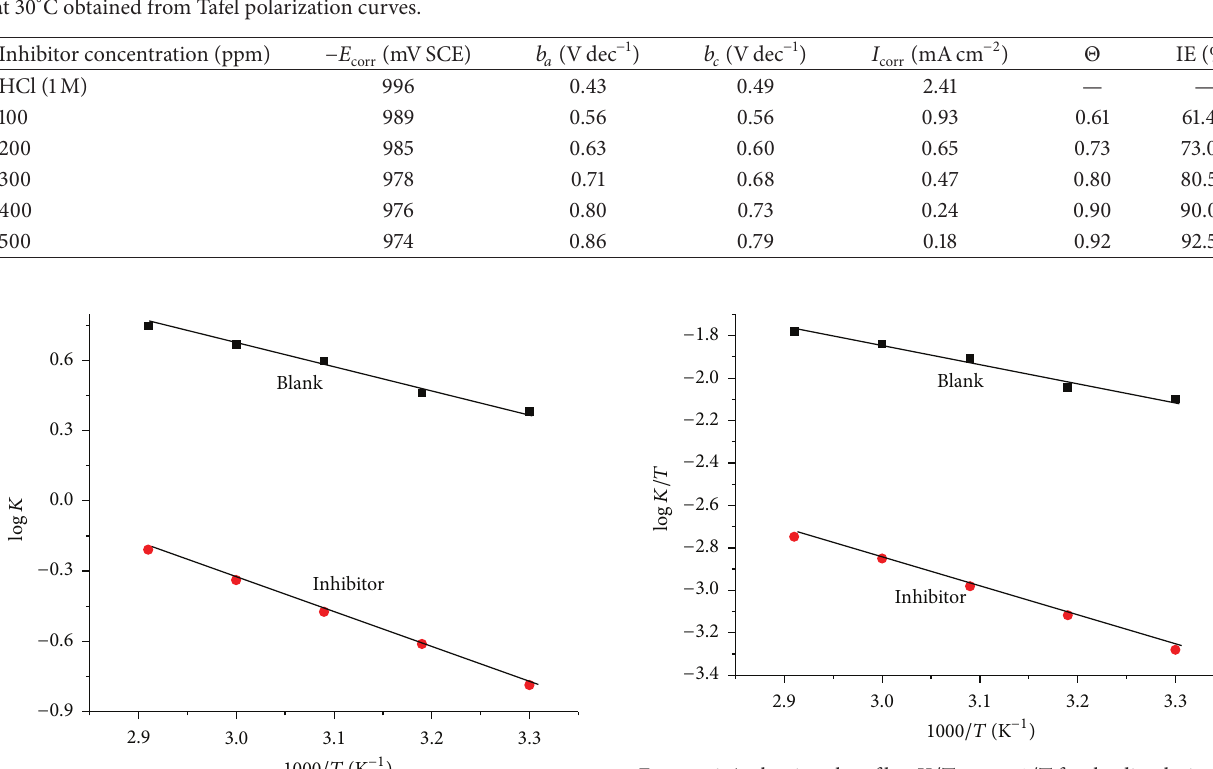
Figure6:Arrheniusplotoflog 𝐾/𝑇 versus 1/𝑇 forthedissolutionof zinc in 1.0M HCl in the absence and presence of Marjoram